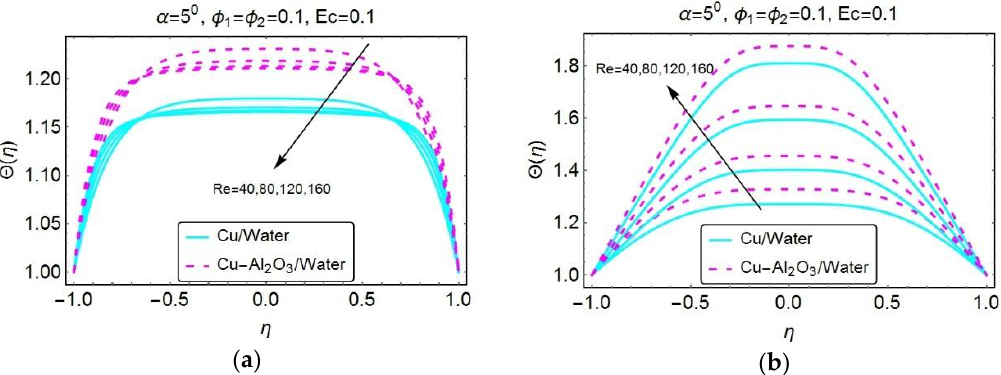
Figure 9. Stimulus of Re on Θ (η) : ( a ) convergent case and ( b ) divergent channel.